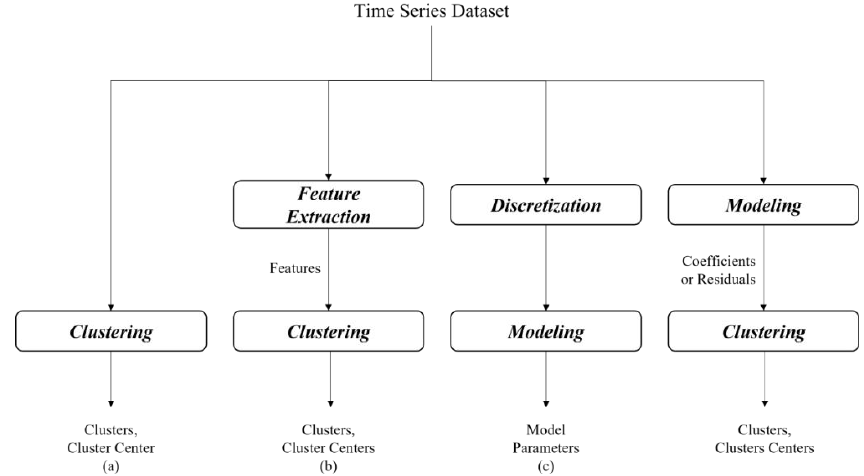
Figure 2. Three time series clustering approaches: ( a ) raw-data-based; ( b ) feature-based; ( c ) model-based.